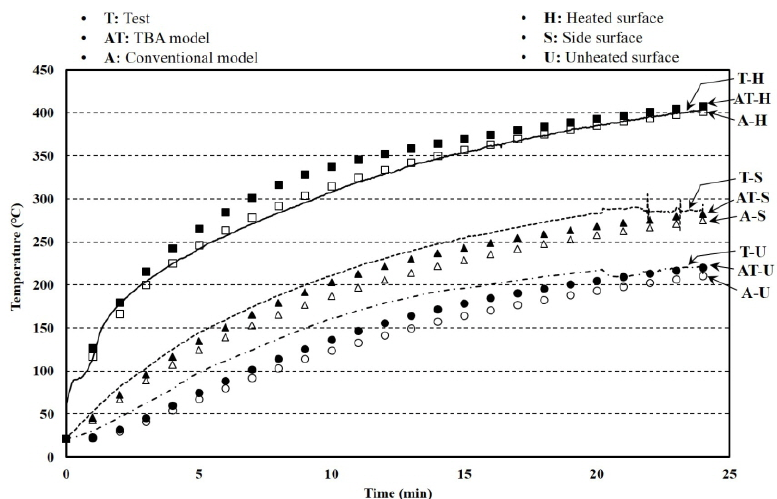
Figure 7. Temperature results of furnace tests and finite element analysis (FEA).